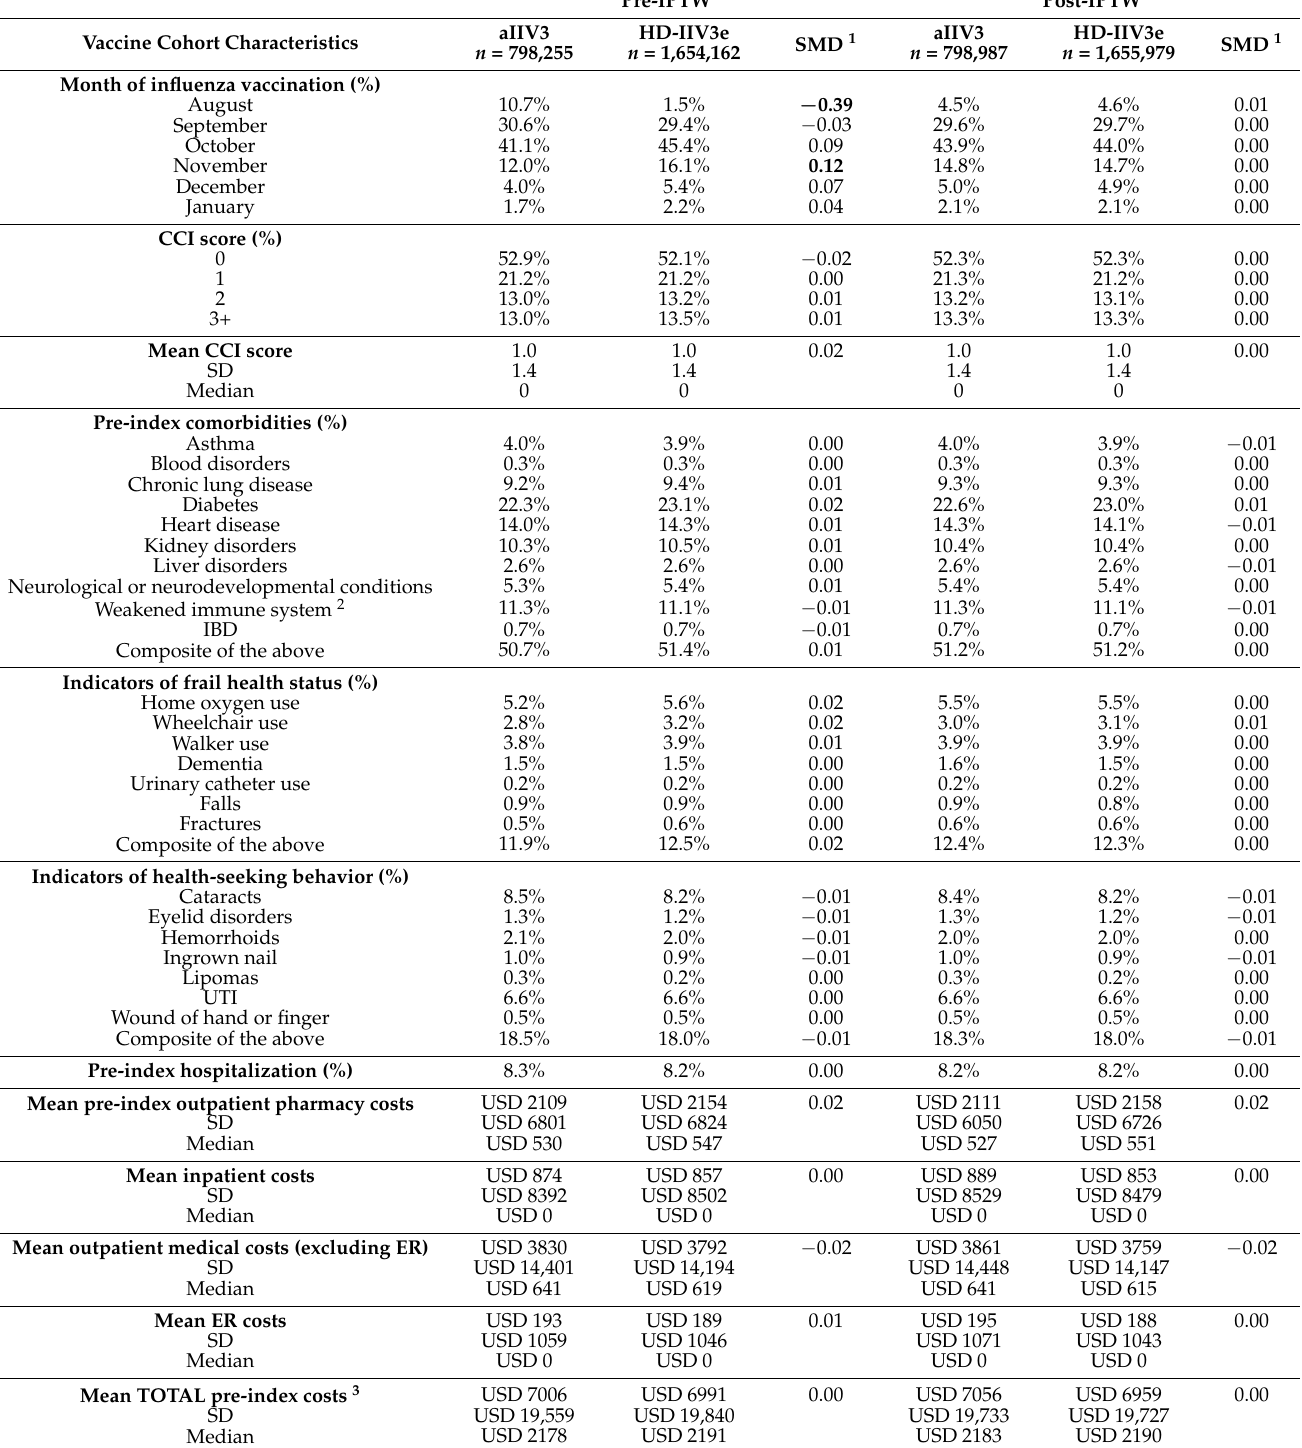
Table 2. Baseline Clinical